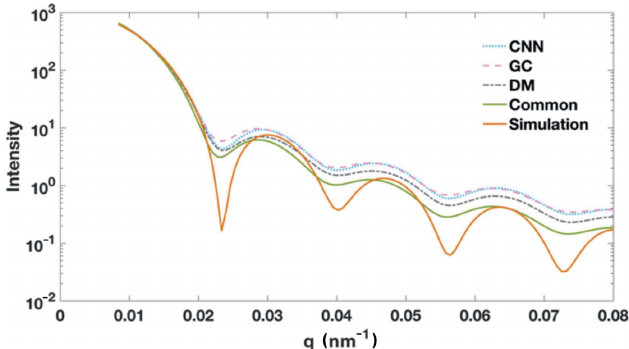
Figure 3 Averaged intensity radial profiles. Here q is calculated by 2sin (cid:6)= 2 ð Þ =(cid:7) , where (cid:6) is the scattering angle and (cid:7) is the wavelength of the X-rays. The profiles are overlaid by the matching intensities at the low- q